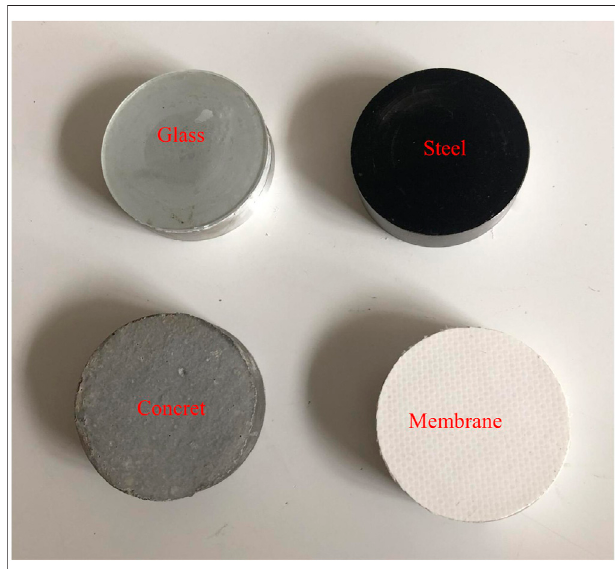
FIGURE 3 | Specimen of the roo fi ng materials.